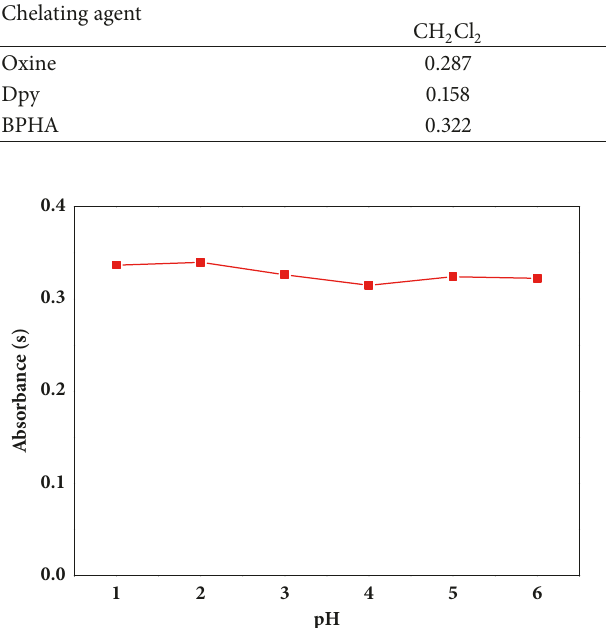
Figure 2: The atomic absorbance of Sb (III) in solutions with the pH value from 2.0 to